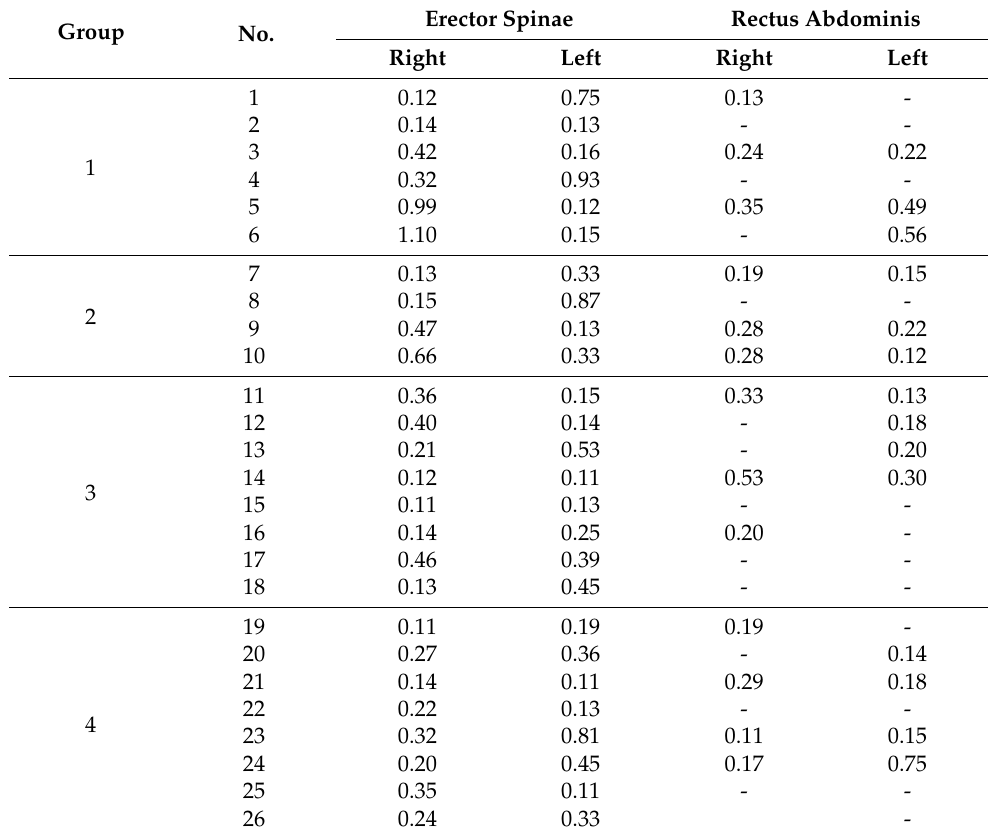
Table 2. Movement time of each participants’ trunk muscles.